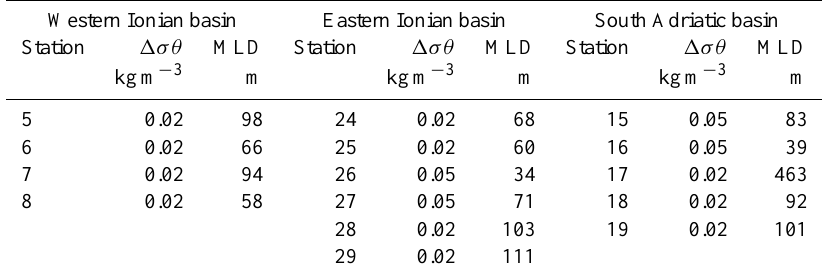
Table 1. MLD calculated from a threshold method at which changes in density from that at the reference depth of 2m are greater than the threshold value ( 1σθ) as indicated. Western Ionian basin Eastern Ionian basin South Adriatic basin Station 1σθ MLD Station 1σθ MLD Station